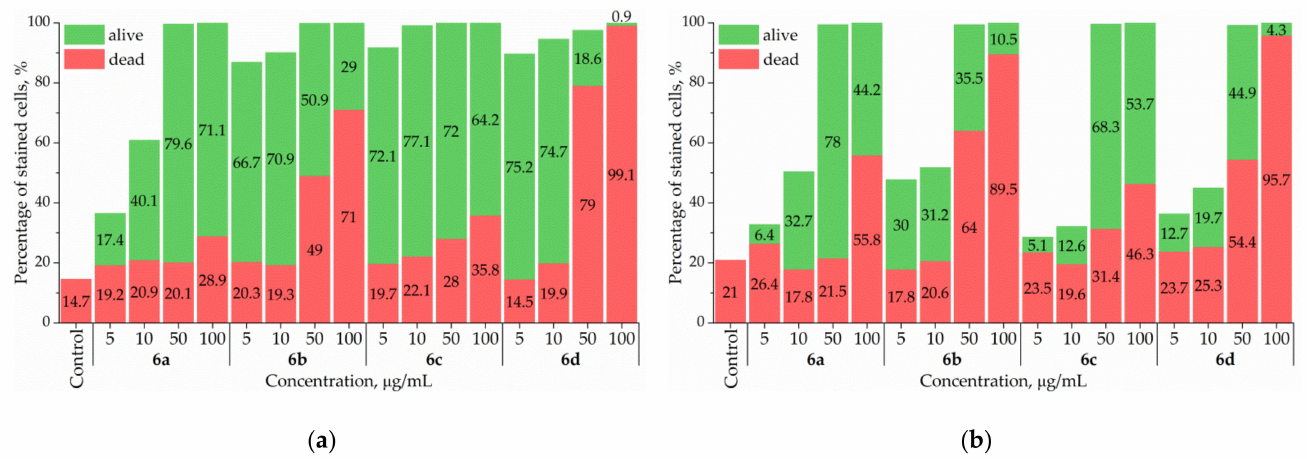
Figure 4. Penetration of thiacalix[4]arenes 6a – d into A549 ( a ) and HuTu-80 ( b ) cells. The ability of macrocycles 6a – d to penetrate into A549 and HuTu-80 cell lines was evaluated. In conclusion, one can say that macrocycles penetrate into living and dead cells; the cytometric cytotoxic profiles confirm the MTT test